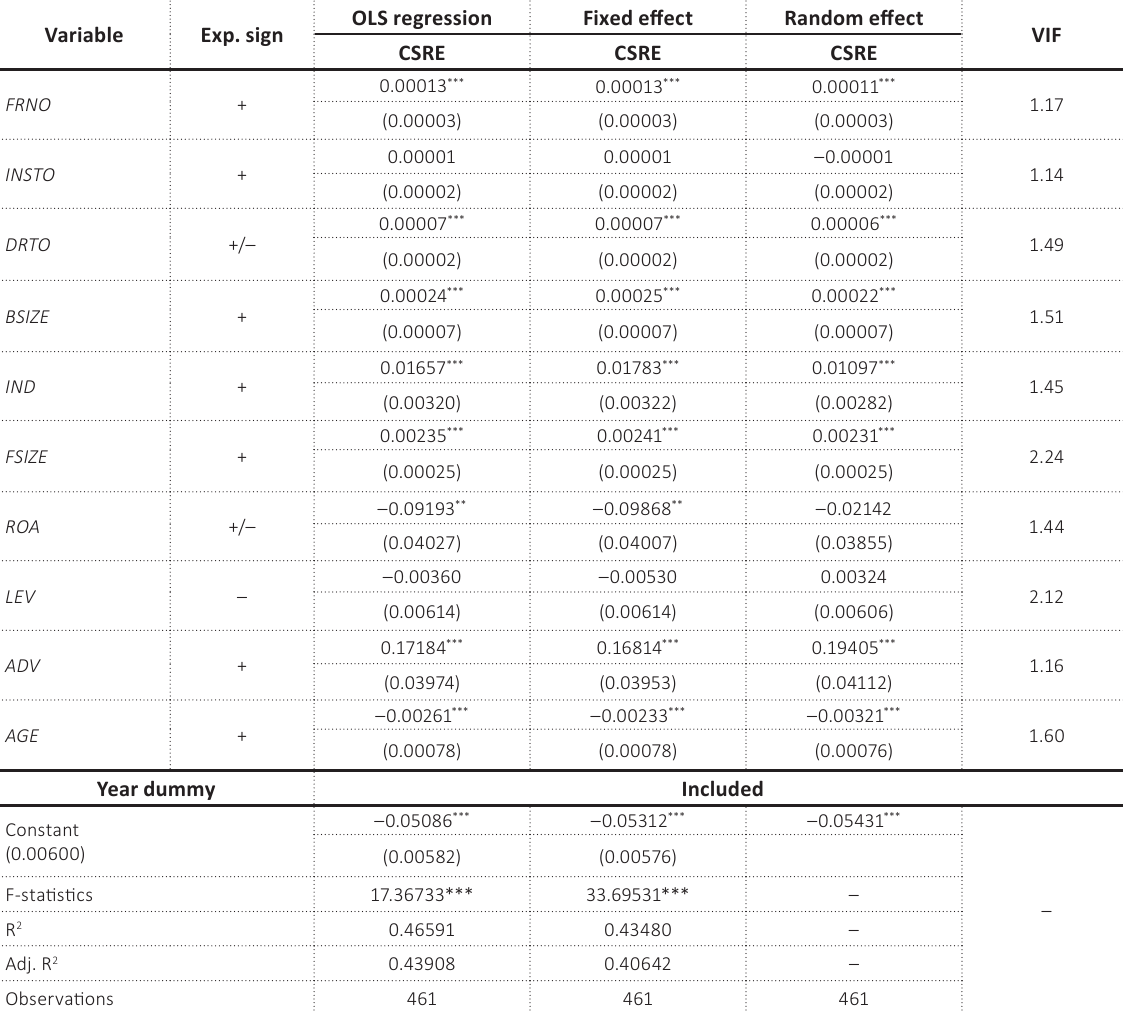
Table 5. Regression